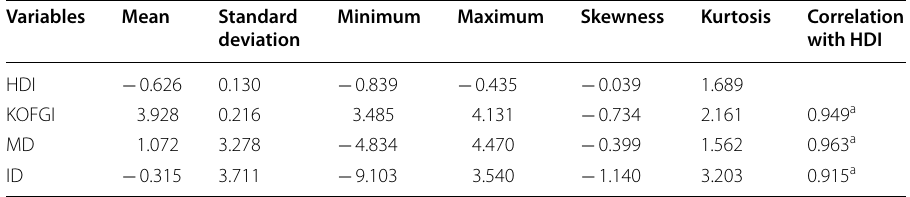
Source: authors’ estimation from UNDP, WDI, and ETH Zurich KOF data a Implies correlation is significant at 1% level